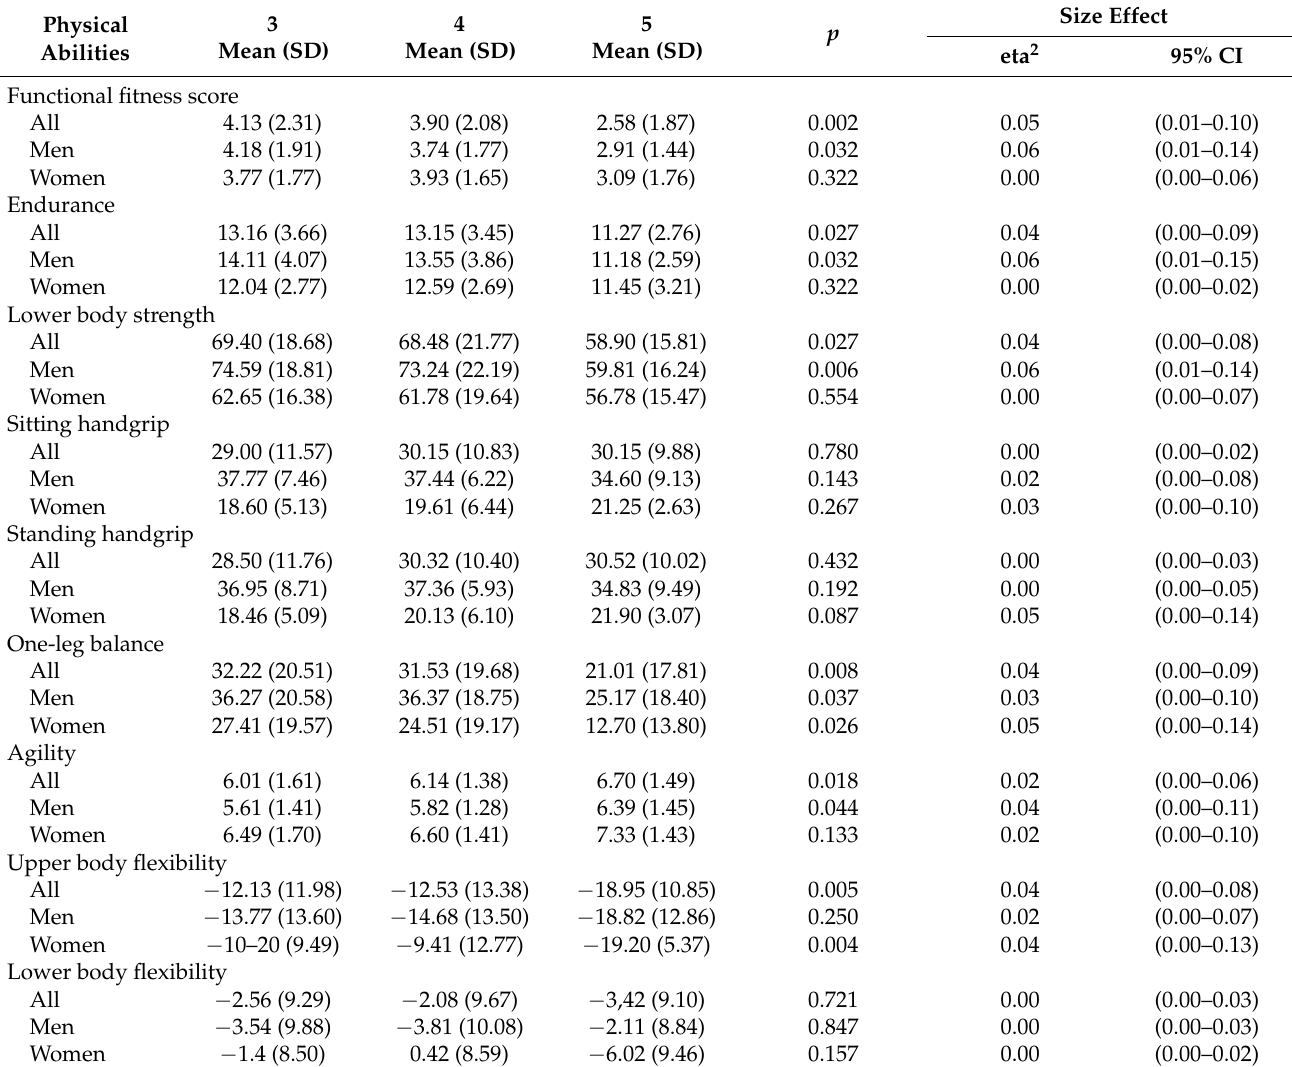
Table 4. Association between number of pathologies and physical abilities measured by functional fitness battery